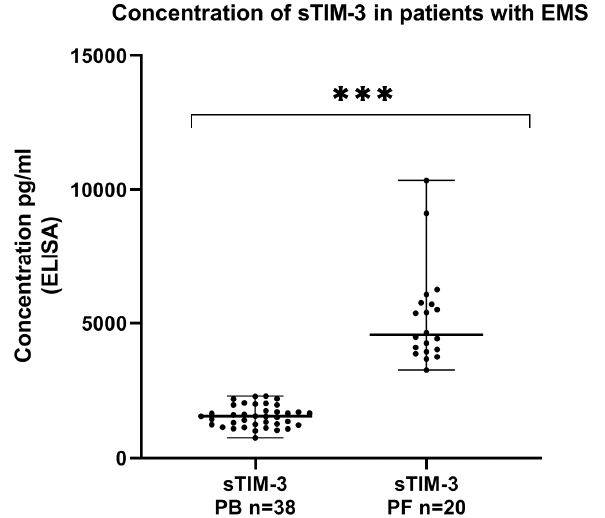
Figure 7. Levels of sTIM-3 (pg/mL) in the plasma and peritoneal fluid of patients with endometriosis. The median value with the following sign indicates statistically significant difference: *** p < 0.001.